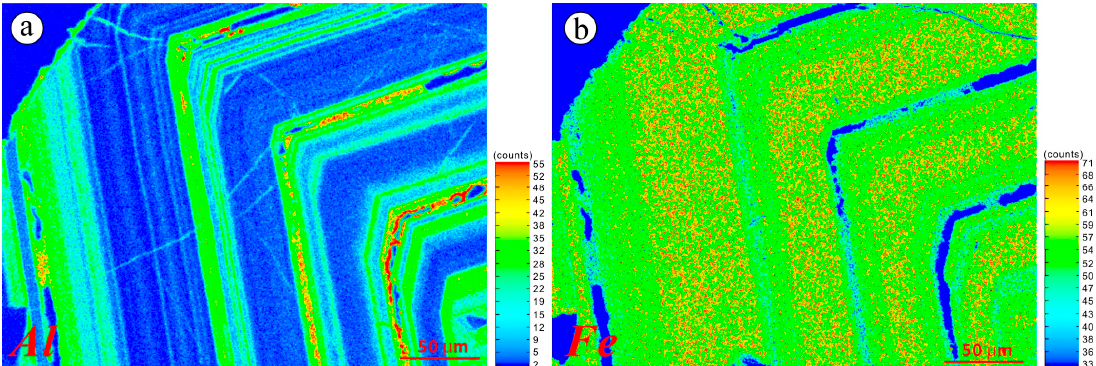
Figure 7. EPMA element mapping of ( a ) Fe and ( b ) Al for a dark red garnet particle.